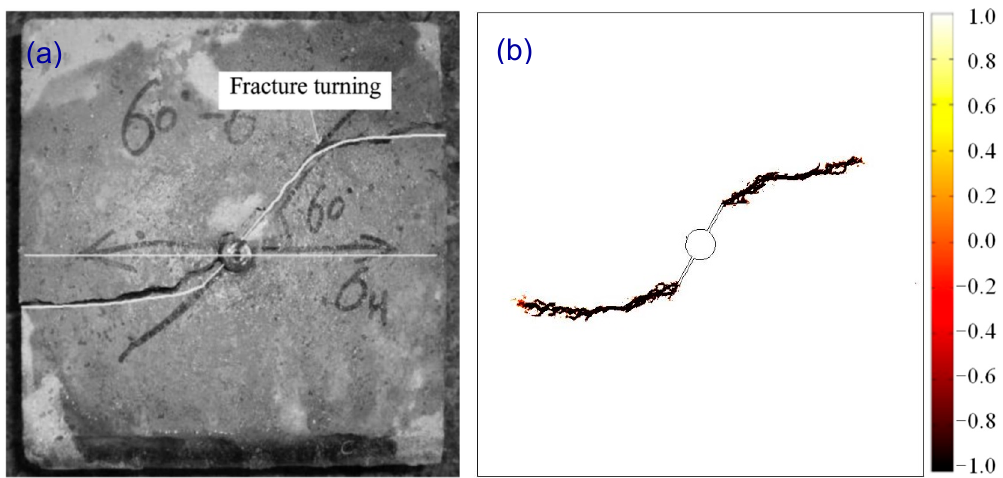
Figure 5. Comparison of model simulation results with experimental results. ( a ) Experimental fracture pattern from Chen et al. [11]. ( b ) Fracture pattern obtained from numerical simulation. Table 1. Comparison of experimental data and numerical data.